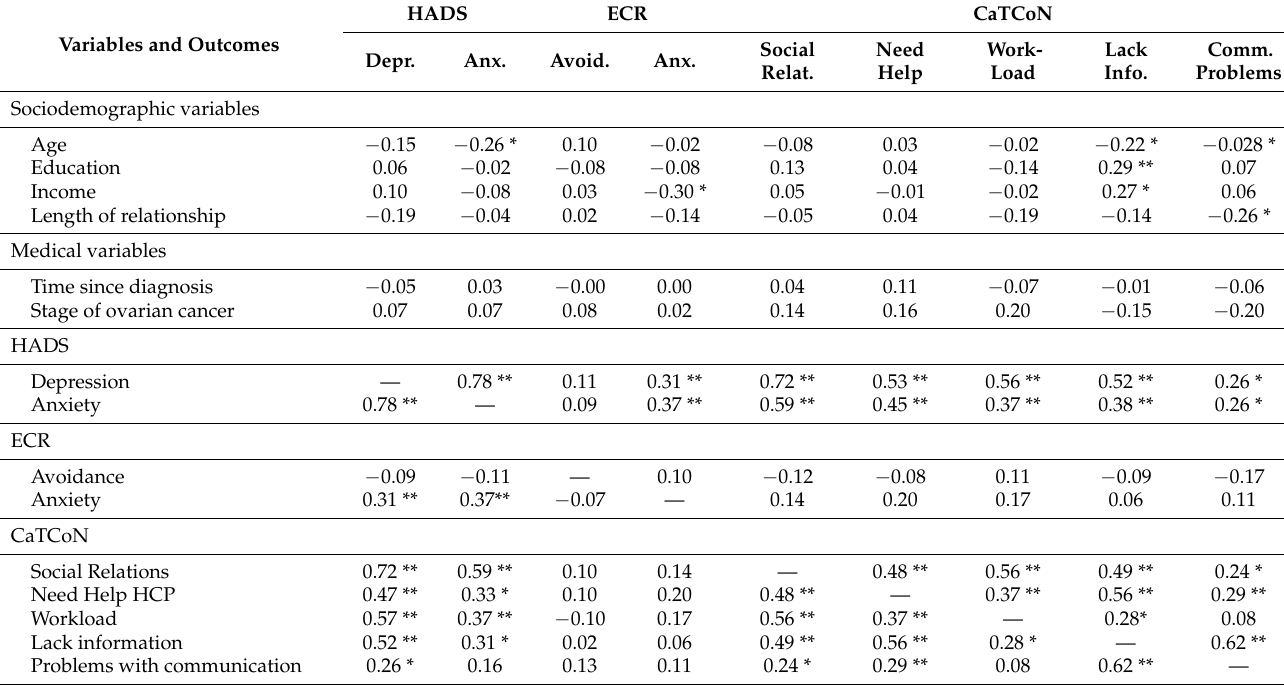
Table 1. Correlations between participant sociodemographic and patient medical variables with distress, attachment insecurity, and caregiving experiences and consequences